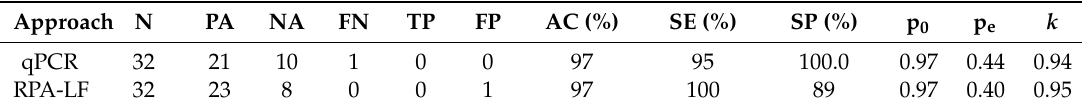
Table 5. Evaluation of the